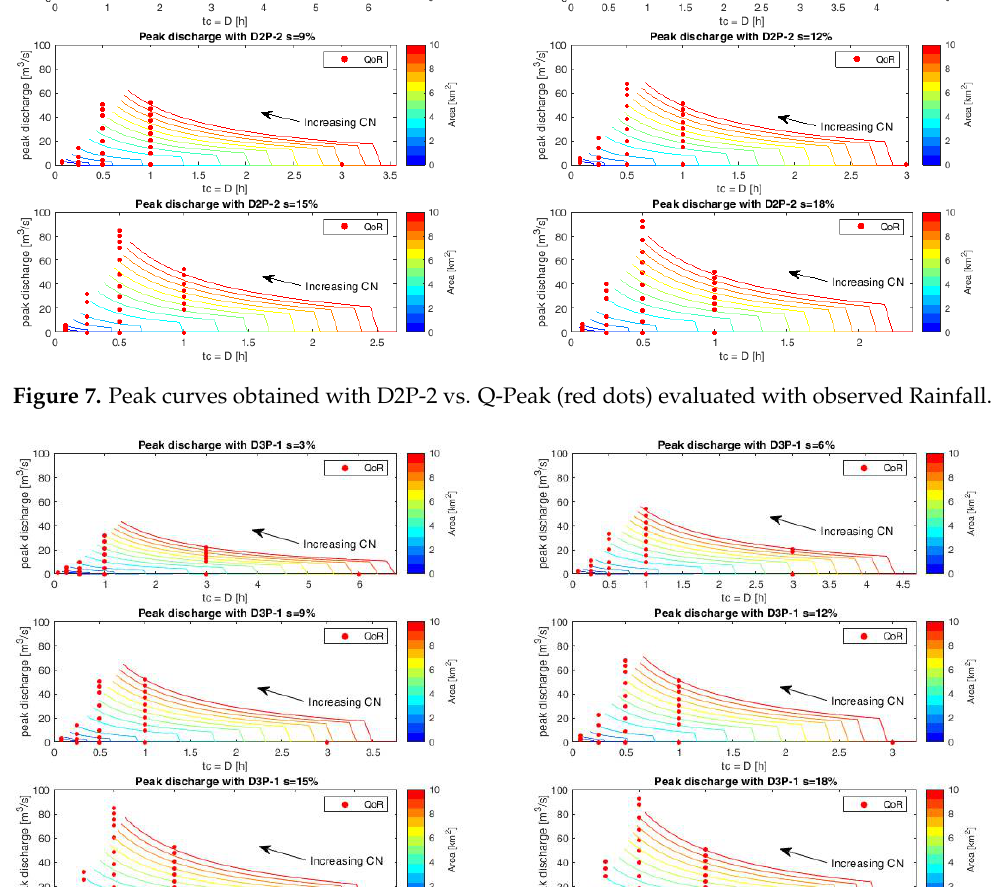
Figure 9. Peak curves obtained with D3P-2 vs. Q-Peak (red dots) evaluated with observed Rainfall.